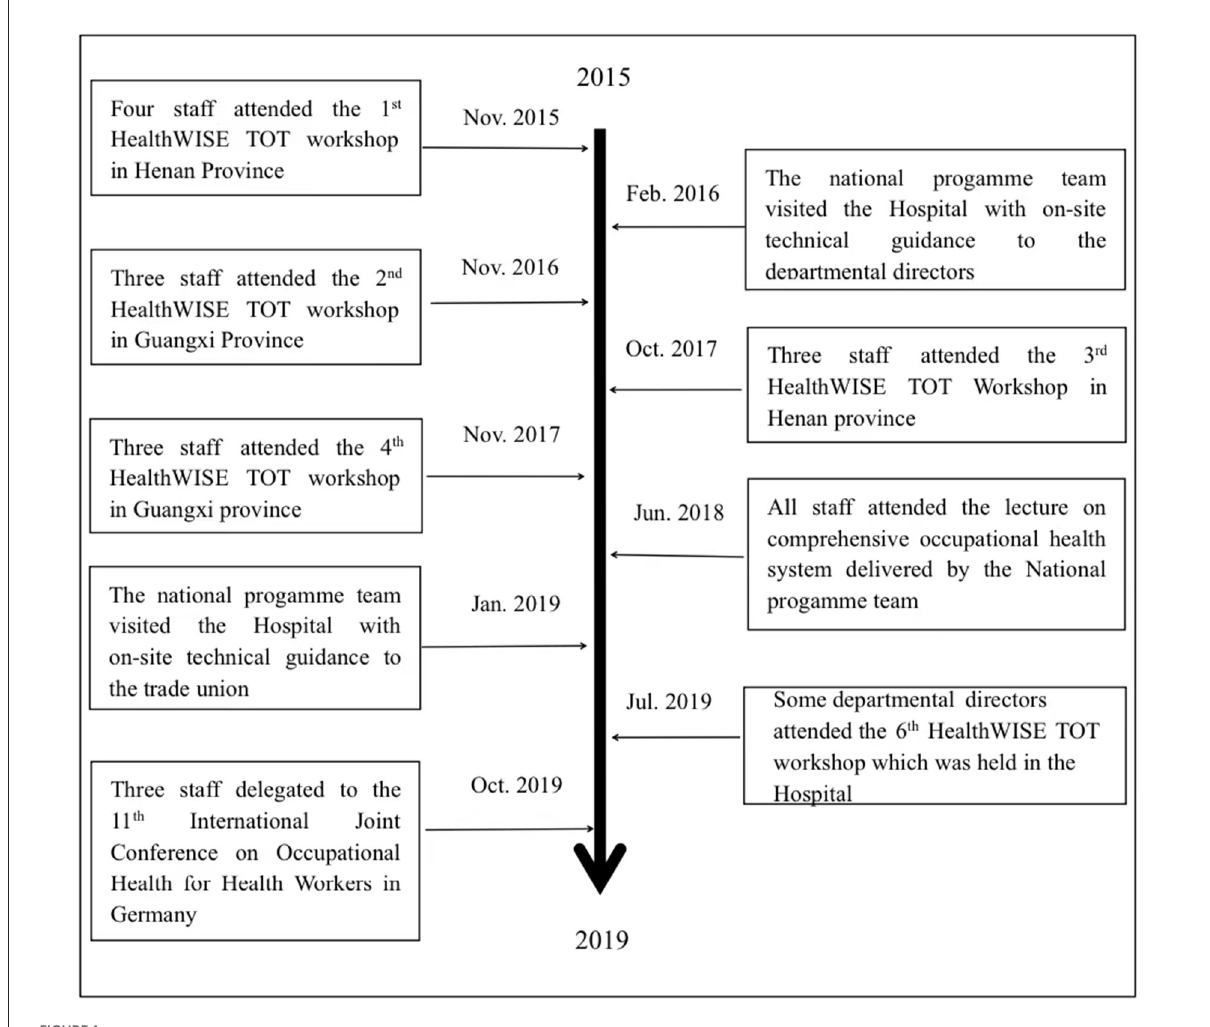
FIGURE1 The milestones of external technical guidance. in the hospital from 2015 to